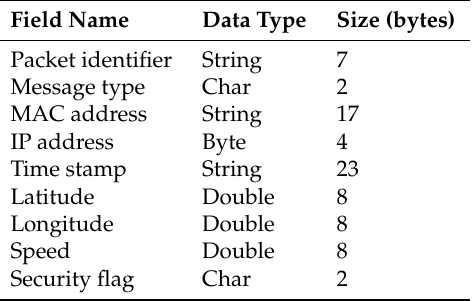
Figure 1. Building blocks of the smartphone-based platform for secure message dissemination. The platform is intended to support both the transmission (TX) and reception (RX) roles to enable a given node behave as source for packet generation, relay for disseminating messages, or as destination node. Specific functions (marked with *) at the TX/RX modules are optional, and should be enabled at the user space (i.e., configuration interface). Table 2. Fields of the generated packets in the